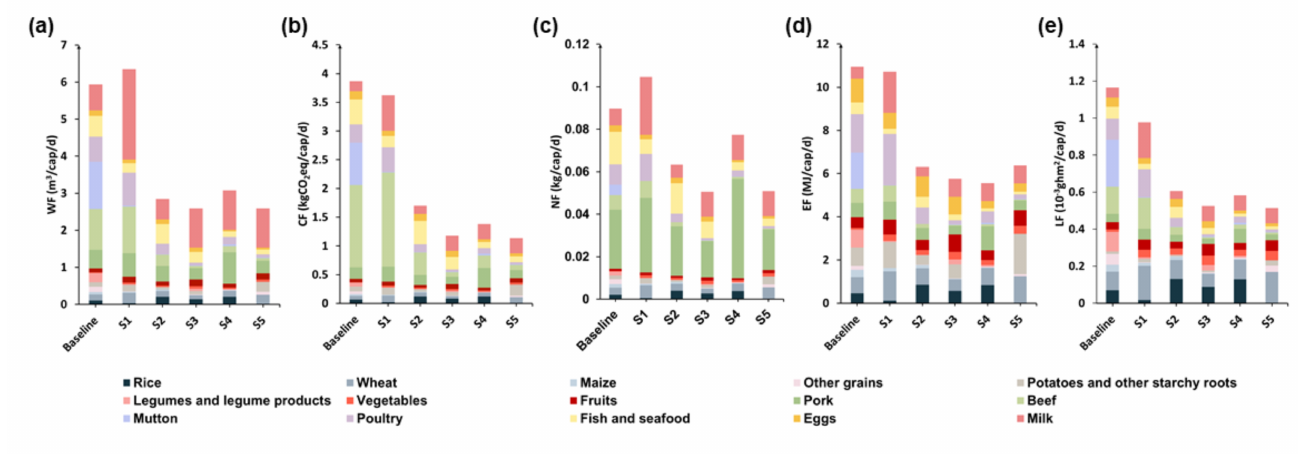
Figure 9. Scenarios analysis for multiple footprints of household under different dietary patterns (( a ) WF; ( b ) CF; ( c ) NF; ( d ) EF; ( e ) LF; Baseline: CHN 2011 [37]; S1: US 2015 [41]; S2: JPN 2015 [42]; S3: Chinese Dietary Guidelines 2016 [43]; S4: Guideline of Australia 2013 [44]; S5: guidelines issued by Germany 2013